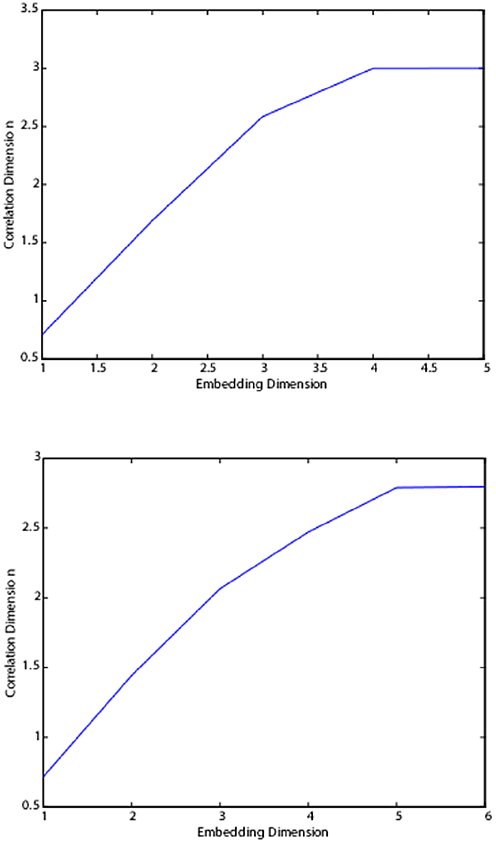
Figure 8. (a) The correlation dimension of the detrended TEC for the quietest day of October at Birnin Kebbi, which saturates at m ≥ 4 and τ = 39. (b) The correlation dimension of the detrended TEC for the most disturbed day of October at Birnin Kebbi, which saturates at m ≥ 5 and τ =